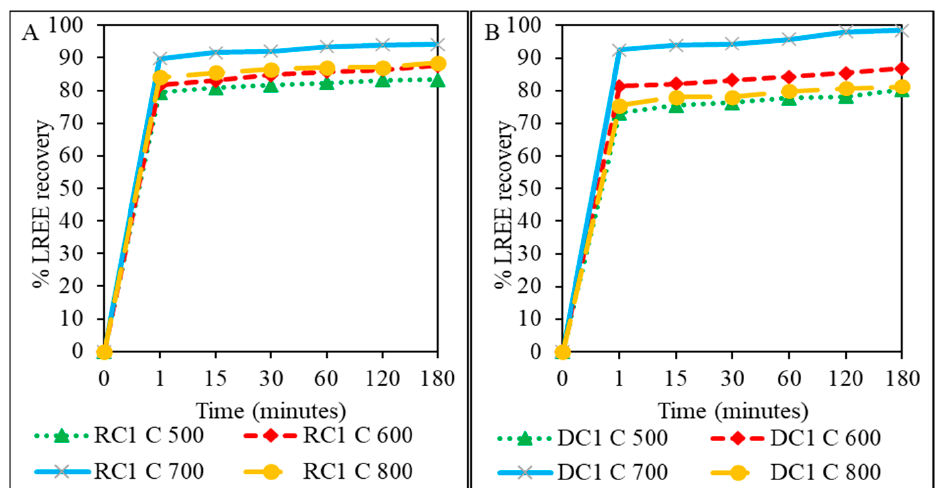
Figure 9. Calcined RC1 ( A ) and DC1 ( B ) % HREE leaching recovery under the optimised leaching parameters of (HCl concentration of 2 M, solid:liquid ratio of 10 g/L, leaching temperature of 50 °C, D 90 = − 106 μ m, stirrer speed 550 rpm).